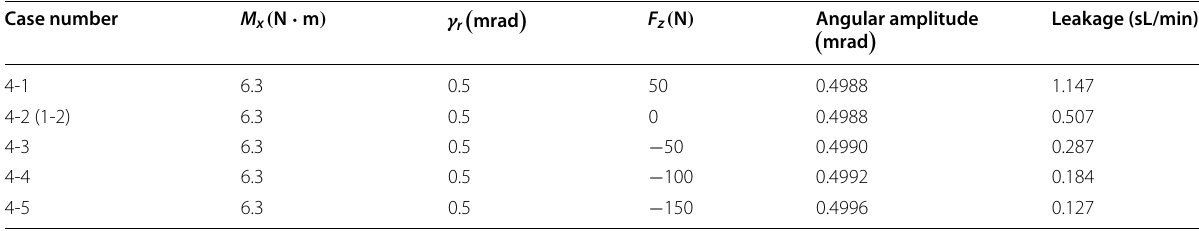
Table 5 Group 4: Varying axial